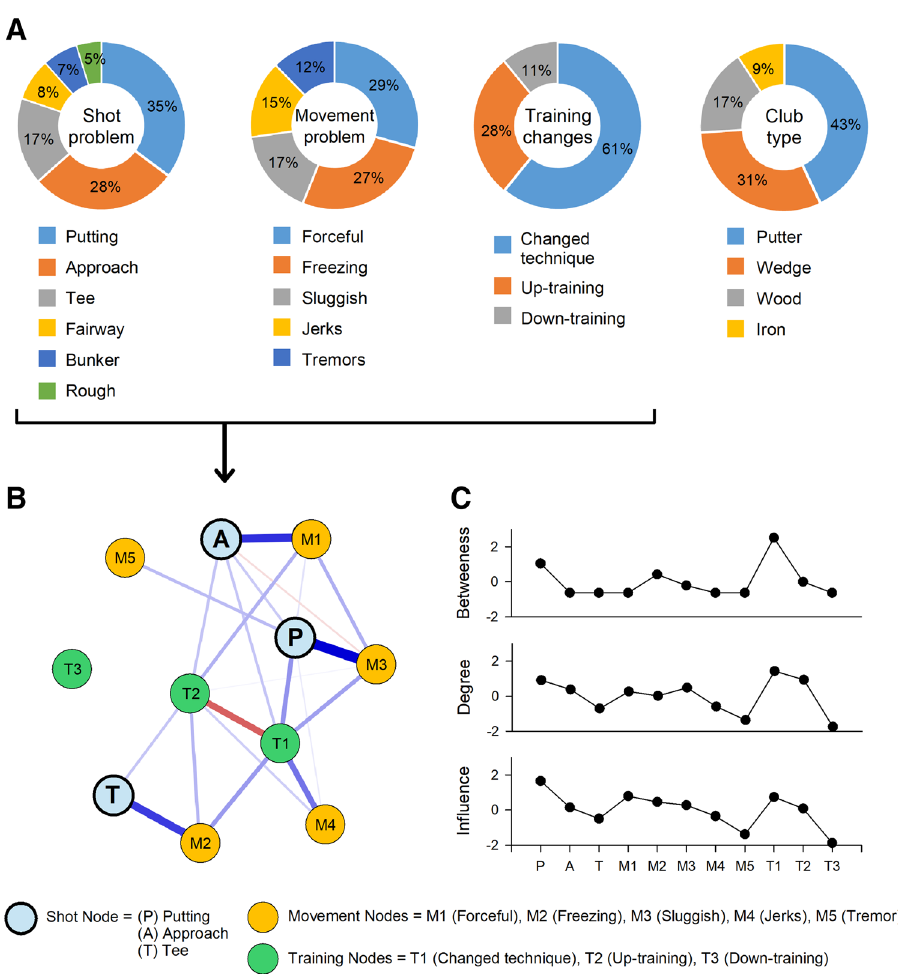
Figure 3. Frequency estimates, network and centrality plot for key factors associated with yips symptoms. ( A ) Frequency estimates of problem types and interventions in yips only golfers (N = 421). ( B ) Network structure for three variables (nodes) = shot-problem, movement-problem and training changes. Network edges were based on an Ising model (hyperparameter = 0.25) wherein blue edges represent positive relationship between the variables and red edges represent negative relationships. The strength of the connection between the nodes was proportional to the thickness of the edges represented between them. Only non-zero edges are shown, with sparsity = 0.56. The distance between the nodes was arbitrary, specified by a value given by the Fruchterman–Reingold algorithm (here = 0.7). The edge-weight stability demonstrating the robustness of the network is summarized in supplementary data. As seen from the network, putting (P), approach (A) and tee shots (T) nodes had strong edge connection to specific movement deficits (slowing, forceful and freezing of swing, respectively) in the network. ( C ) Centrality plot with respect to the network structure was explained via betweenness, degree and the explained influence of the variables (nodes) in the network. The X and Y axes specify the nodes and the indices respectively. Putting shots along with their predominant training patterns i.e. changing technique and increasing the frequency of training had strong degree centrality with significant influence on yips-golfers’ characteristics within the